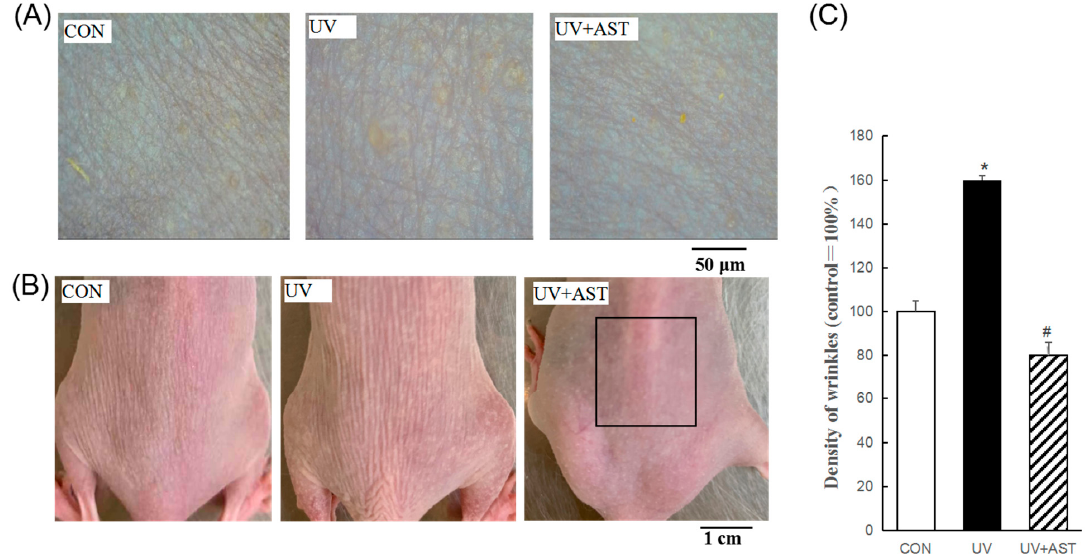
Figure 1. The e ff ects of AST on the dorsal skin of ultraviolet (UV)-treated mice. ( A ) Photographs and replicas of the mouse dorsal skin. Scale bar = 50 µ m. ( B ) Photographs of the mouse dorsal skin. Scale bar = 1 cm. ( C ) Histograms of the replica analysis. AST treatment improved the visible skin condition, reduced the proportion of wrinkle area to skin area (%), and the mean area of wrinkles in UV-induced mice. * p < 0.01 and # p < 0.01 vs. Control mice; # p < 0.01 vs. UV-treated mice.